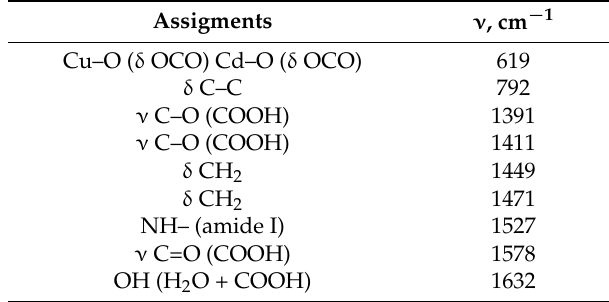
Table A1. AB and assignments for the Fe 3 O 4 /NH 2 -SiO 2 -DTPA-Cu/Cd nanocomposites.